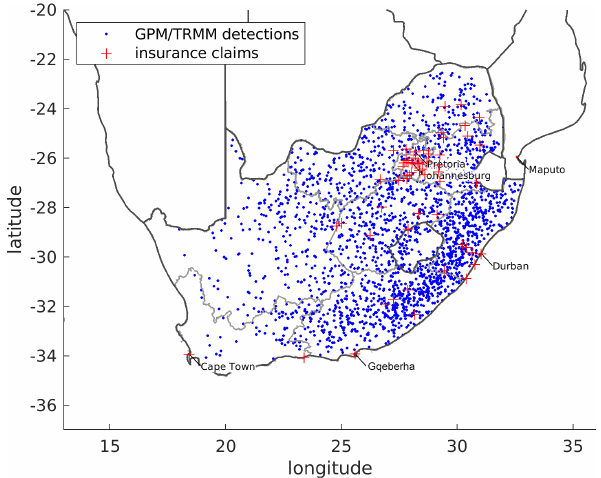
Figure 4. Claims locations of hail damage in South Africa (1984– 2017) and passive microwave detections (1998–2018) in the model